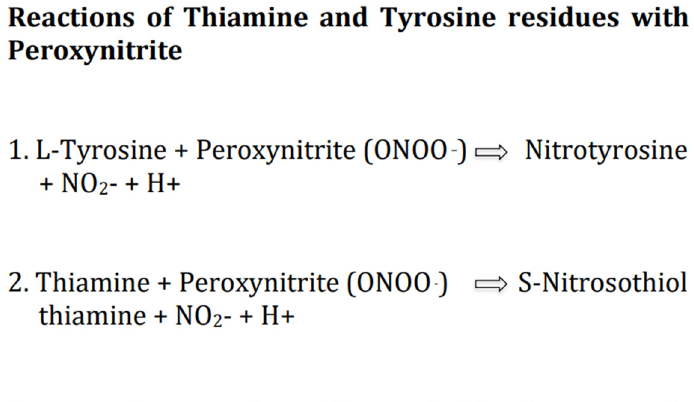
Figure 2. Competing effects of thiamine on tyrosine residues peroxynitrite binding. For reactions 1 and 2, see also references [60,80].